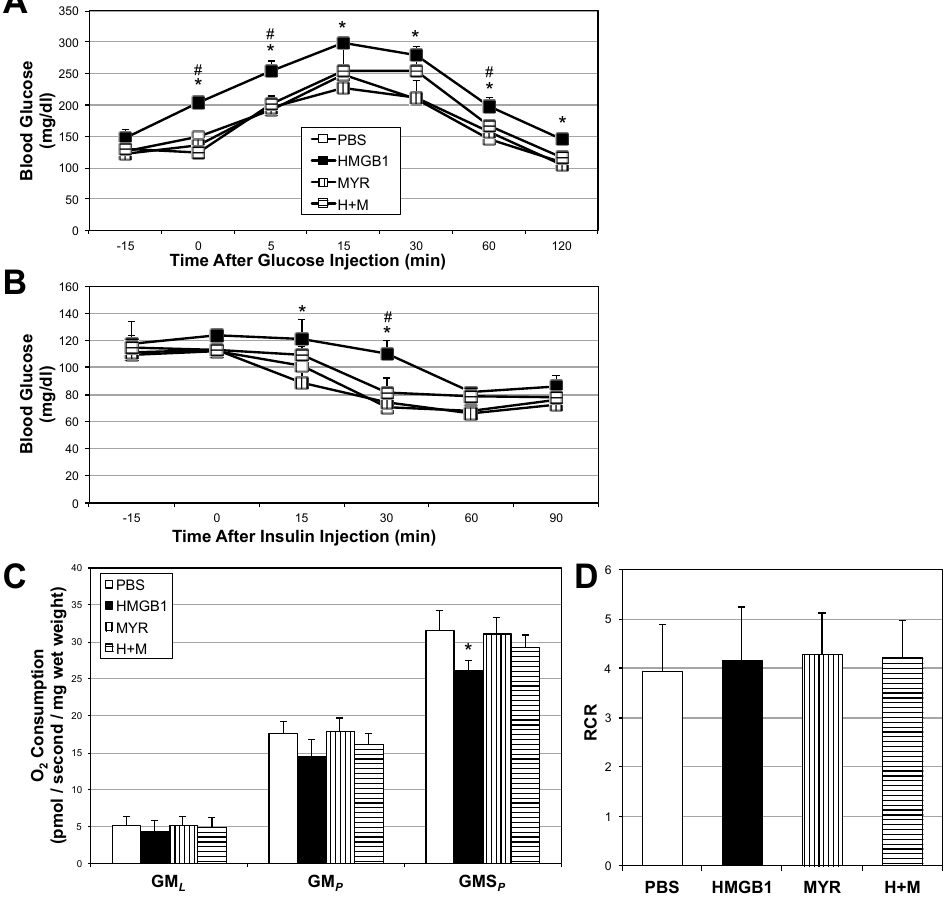
Figure 6. HMGB1 disrupts metabolic function in mice. Following 14 days of placebo (CON), HMGB1 (1 μ g/day), myriocin alone (MYR; 3 μ g/kg thrice weekly), or myriocin + HMGB1 for 14 days ( n = 6), intraperitoneal glucose ( A ) and insulin ( B ) tolerance tests were performed on 12–14-wk old male mice ( n = 6). Mitochondrial respiration was determined on harvested red gastrocnemius ( C ) ( n = 6) and respiratory control ratio was determined by GM P /GM L ( D ) ( n = 6). * p < 0.05 vs. CON. # p < 0.05 vs. HMGB1.